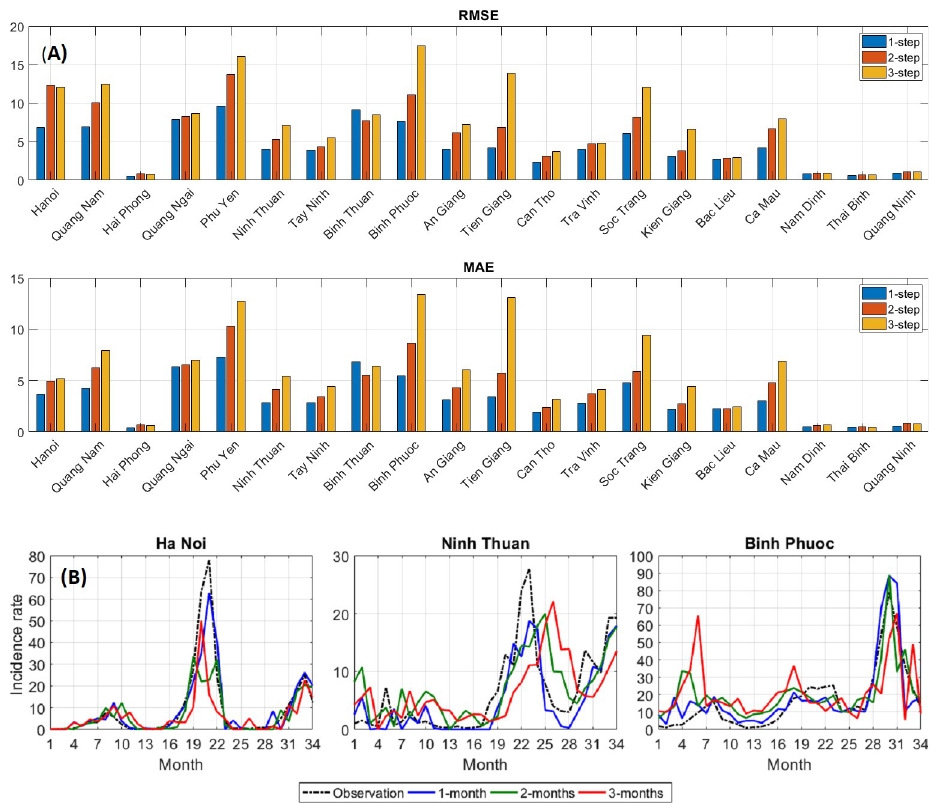
Fig 7. Performance of multi-step ahead predictions of LSTM-ATT for all provinces. Error metrics are displayed for all 20 provinces (Fig 7A for RMSE and middle for MAE) in addition to the predicted and observed incidence rates per 100,000 population in three provinces (Fig 7B). LSTM-ATT = attention mechanism-enhanced LSTM. RMSE = root mean square error. MAE = mean absolute error.